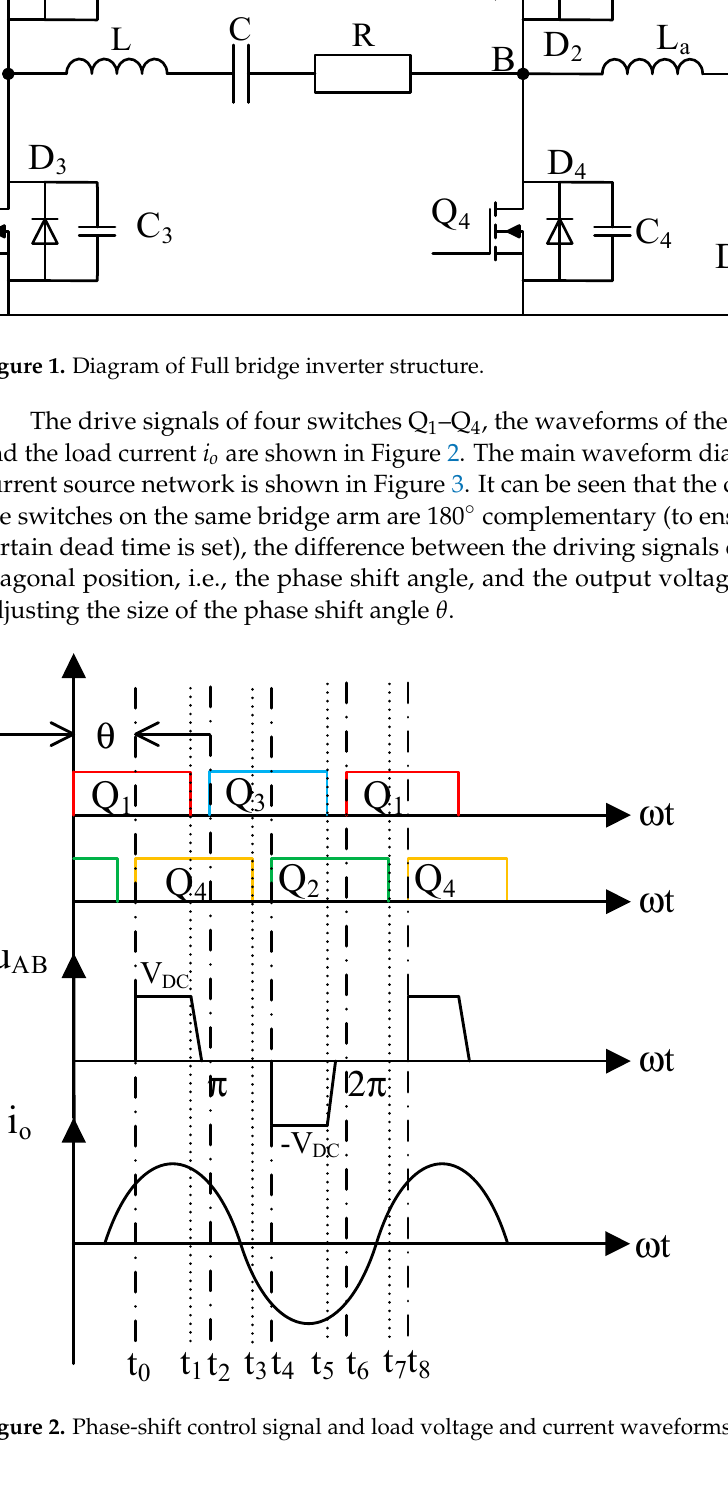
Figure 1. Diagram of Full bridge inverter structure.